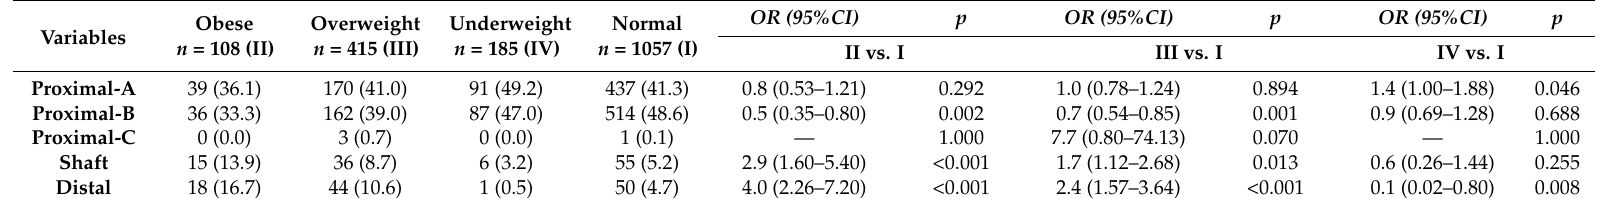
Table 3. Location of femoral fracture in patients with different weight classes in fall accidents.